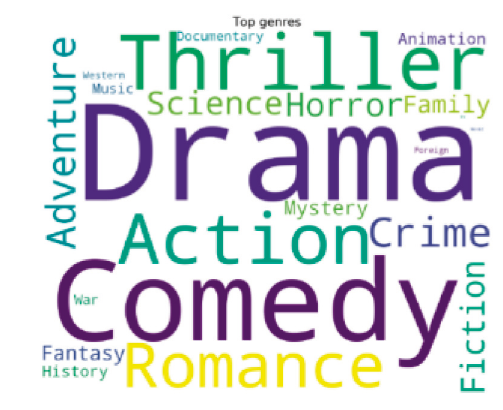
Figure 4: Movie genre word cloud.